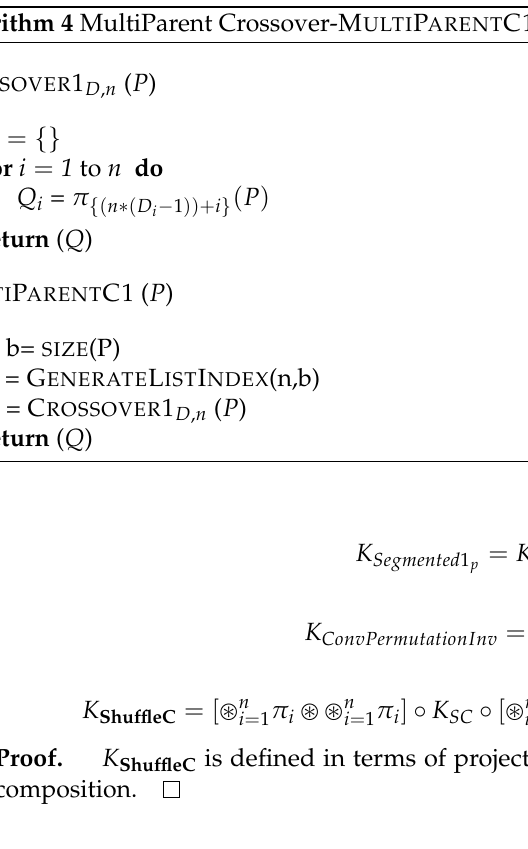
Algorithm 5 Shuffle Crossover-S HUFFLE